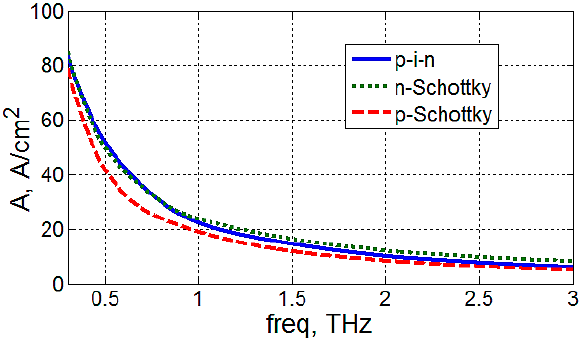
Figure 10. Amplitude-frequency characteristics of different types of GaAs photodetectors calculated at the frequency ranging from 300 GHz to 3 THz. the frequency ranging from 300 GHz to 3